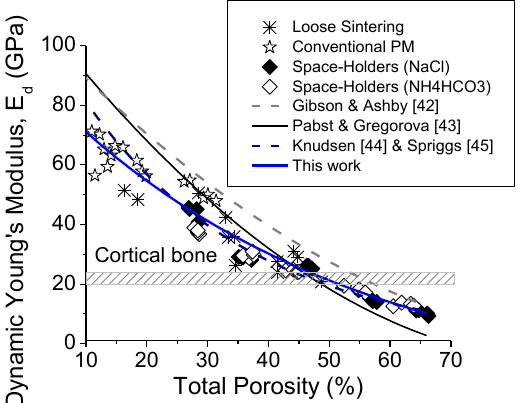
Figure 2. Dynamic Young modulus vs. total porosity: Influence of the manufacturing route.